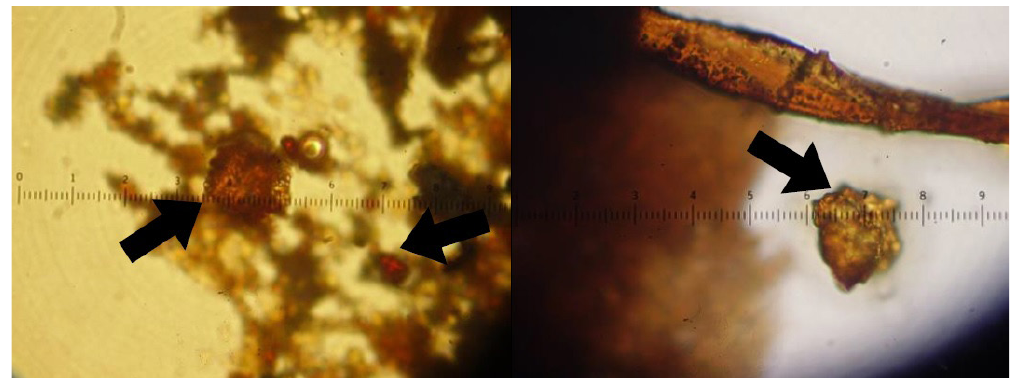
Figure 11. a) Ferrogram after heating with 2% contamination and 500X zoom on the left side; b) Ferrogram after heating with 5% contamination on the right side and 500X zoom. Source: Author’s own